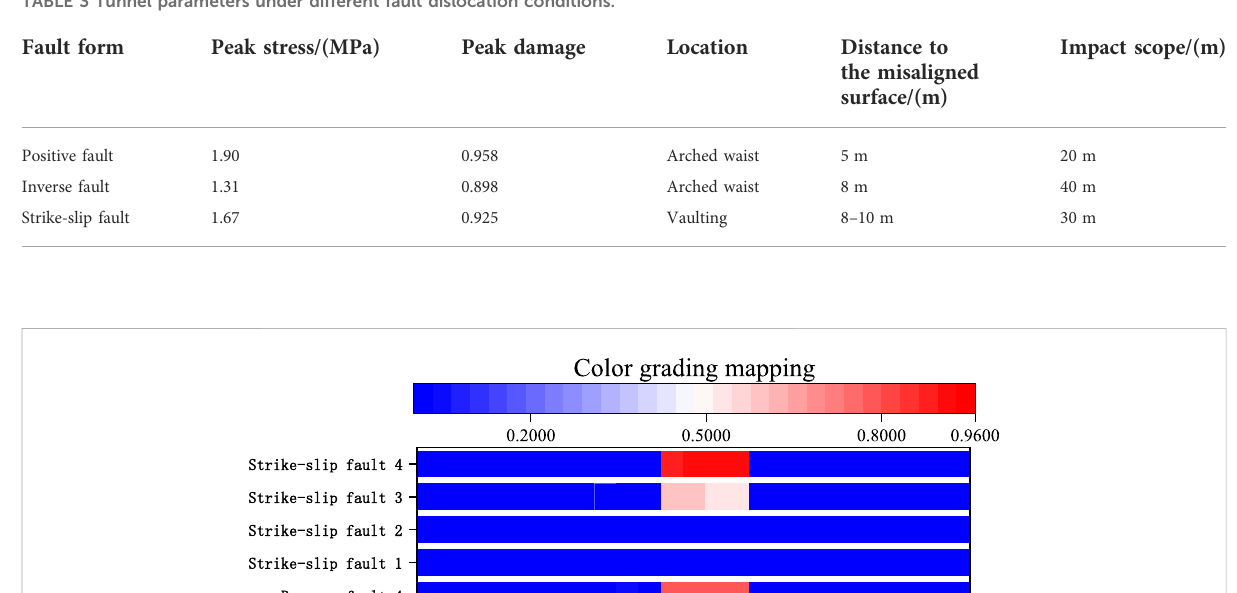
TABLE 3 Tunnel parameters under different fault dislocation conditions.